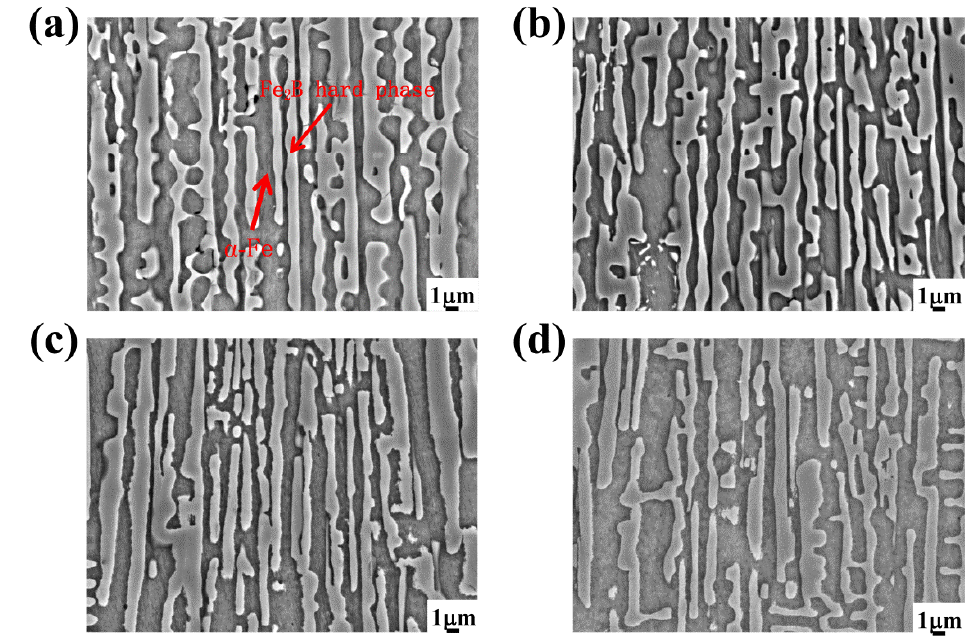
Figure 4. SEM micrographs of the as-cast microstructures: ( a ) A1, ( b ) A2, ( c ) A3, ( d ) A4.